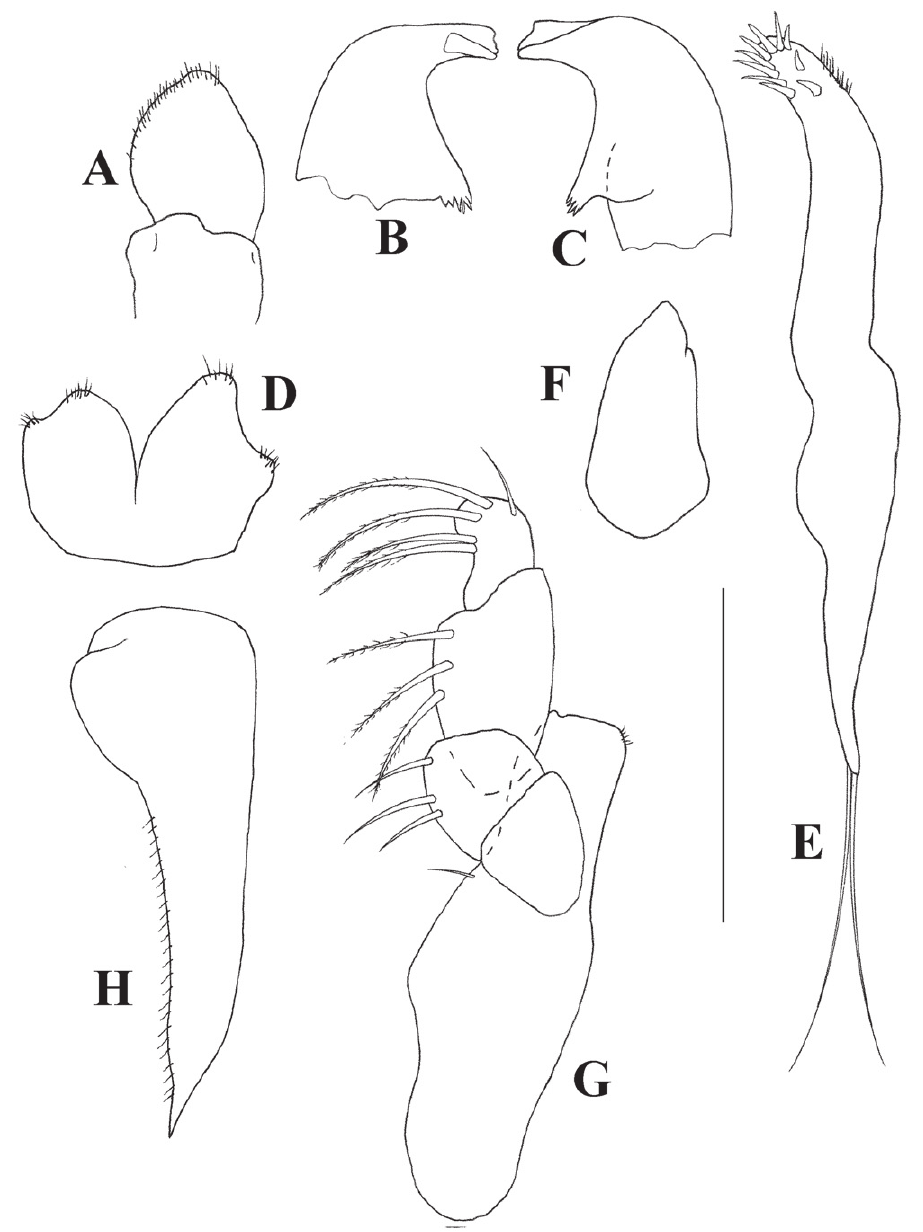
Figure 2. Collettea longisetosa sp. n ., male. Holotype A labrum B left mandible C right mandible D labium E maxillule F maxilla G Maxilliped H epignath. Scale bars = 0.1